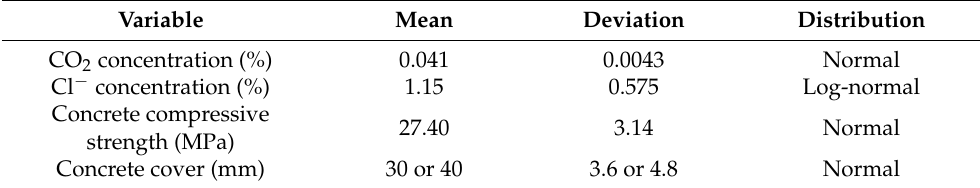
Table 6. Statistical parameters of CO 2 and Cl − , compressive strength, and concrete cover